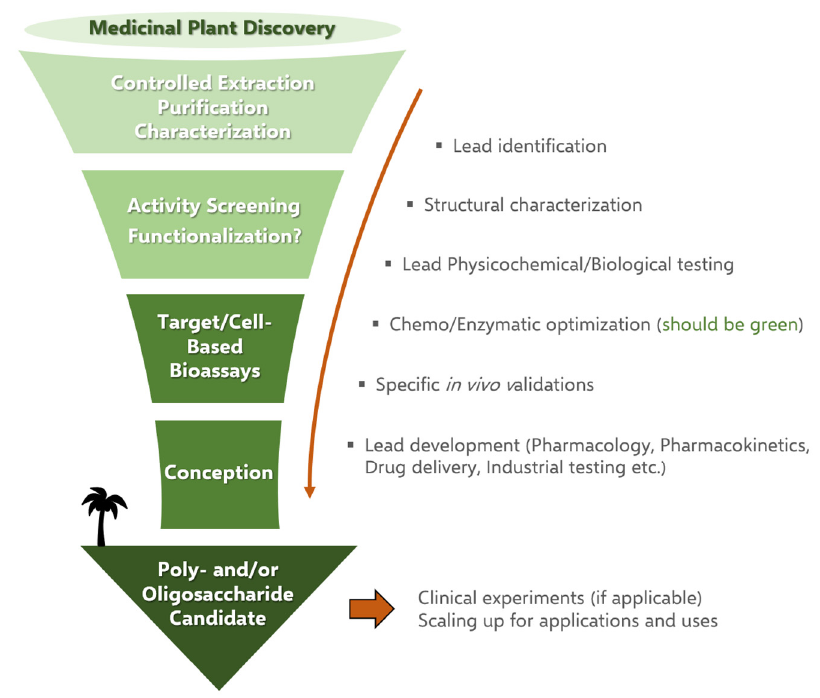
Figure 1. Conceptual approach for exploring the potential of African polysaccharides.